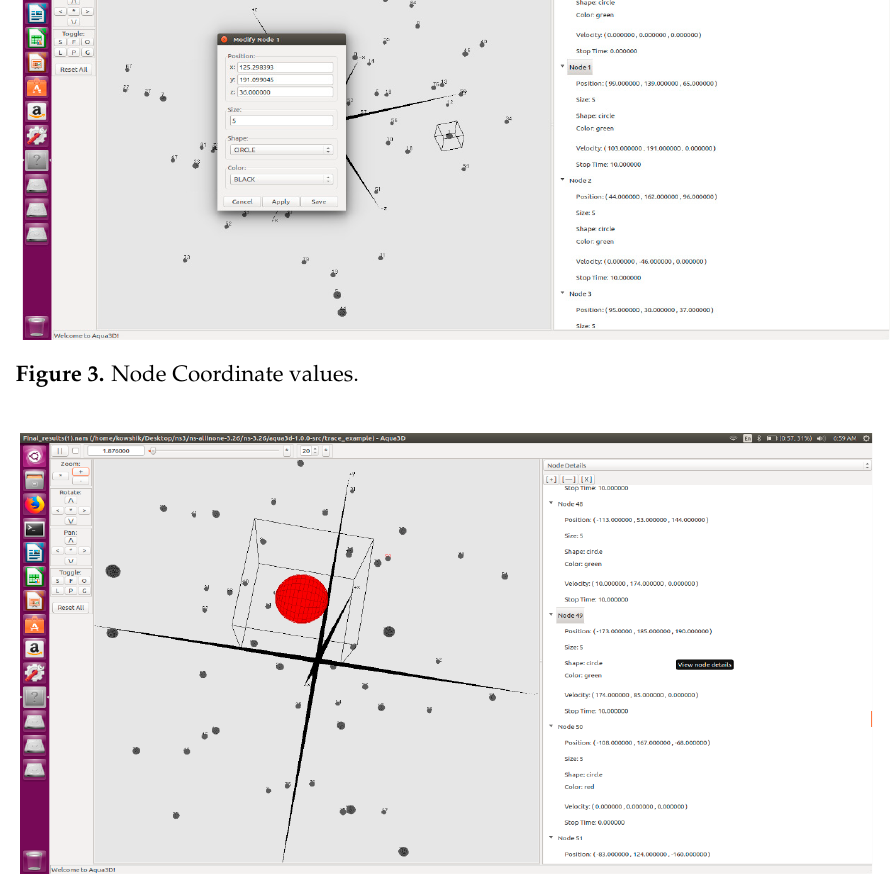
Figure 4. Node location values being updated during simulation. Photonics 2022 , 9 , x FOR PEER REVIEW